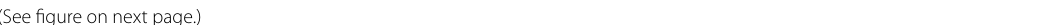
figure on next Fig. 8 Inhibition of P2X7R attenuated IS-induced neuronal loss in the cerebral cortex and hippocampus. ( a - e ) Representative crystal violet images and quantification illustrating increased Nissl-positive neurons in the cerebral cortex of IS-BBG mice compared to IS-VEH mice. The number of Nissl-positive neurons in hippocampal CA1, CA2, CA3 and DG was similar between IS-BBG mice and IS-VEH mice. Magnification Scale bar, 20 μm. ( f - j ) Representative Luxol fast blue stained images and quantification illustrating no significant difference in white-matter integrity in the corpus callosum (medial), corpus callosum (paramedian), caudoputamen, internal capsule and optic tract among the four groups. Magnification 20. Scale bar, 20 μm. All images were taken under identical exposures and conditions. n × and *** p < 0.001 as compared to sham-VEH mice; + p < 0.05, ++ p < 0.01 and +++ p < 0.001 as compared to IS-VEH mice. One-way ANOVA with Tukey’s multiple comparisons or Kruskal–Wallis with Dunn’s multiple comparisons test were performed for statistical analysis. Data are represented as mean SEM. Abbreviations: IS, inflammatory soup; BBG, brilliant blue G; VEH, vehicle; DG, dentate ±